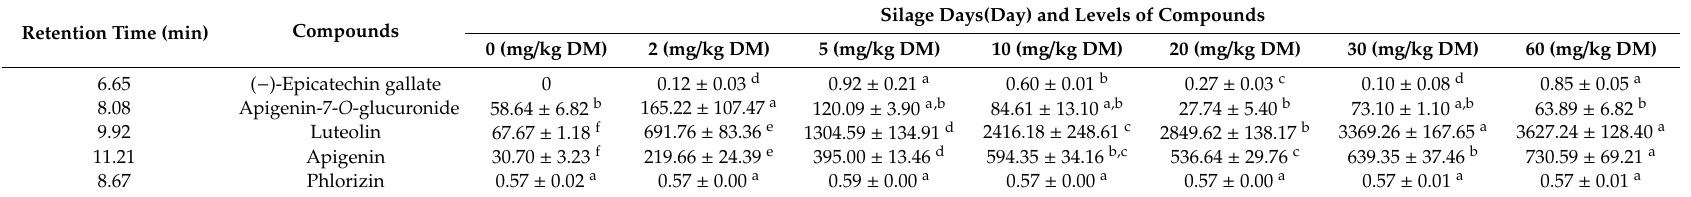
Table 2. E ff ects of silage on flavonoid composition in artichoke